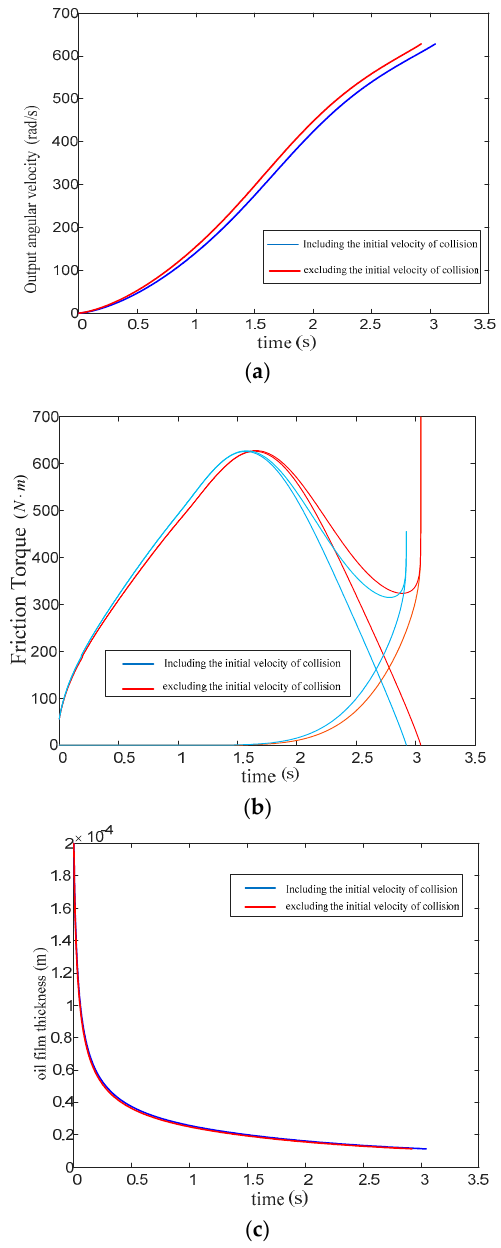
Figure 13. E ff ect of lubricant viscosity on the output speed, friction torque, and film thickness. ( a ) E ff ect of lubricant viscosity on the output speed; ( b ) E ff ect of lubricant viscosity on friction torque; ( c ) E ff ect of lubricant viscosity on oil film